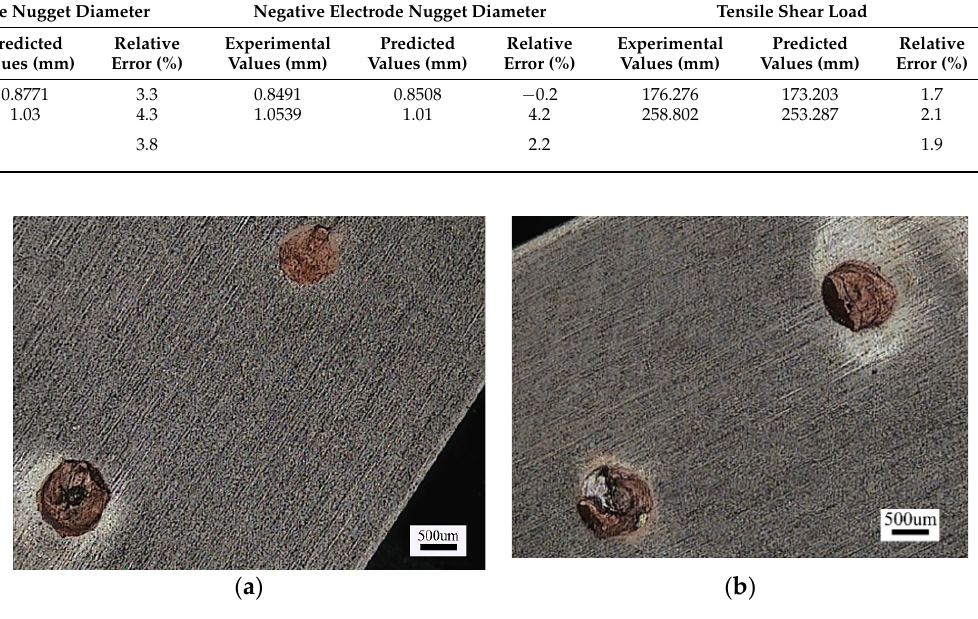
Figure 8. Method I validation figure. ( a ) Proof diagram for welding parameters {2173 , 2, 2, 2100, 3.5,